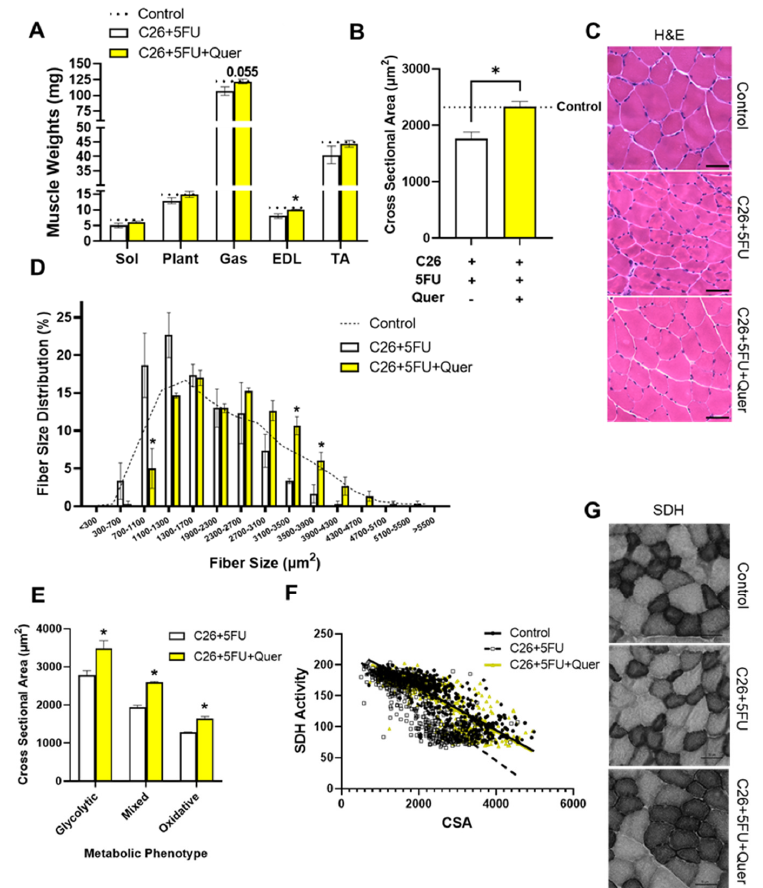
Figure 2. Quercetin increased muscle cross sectional area and succinate dehydrogenase activity. ( A ) Hindlimb muscle weights given in milligrams (mg) — soleus (Sol), plantaris (Plant), gastrocnemius (Gas), extensor digitorum longus (EDL), and tibialis anterior (TA). ( B ) Mean myofibrillar cross sectional area (CSA) in micrometers 2 ( µ m 2 ) obtained from ( C ) hematoxylin and eosin stained (H&E) TAs. ( D ) myofibrillar size distribution given in relative percent across increasing fiber sizes ( µ m 2 ). ( E ) Mean CSA in µ m 2 across glycolytic, mixed, or oxidative fiber types obtained from succinate dehydrogenase (SDH) stained TAs. ( F ) plotted linear relationshi p between single myofiber SDH activity and fiber size. ( G ) Representative SDH images. Scale bar — 50 µ m. Unpaired t -test between C26 + 5FU and C26 + 5FU + Quer. n = 3 – 5/group. * p ≤